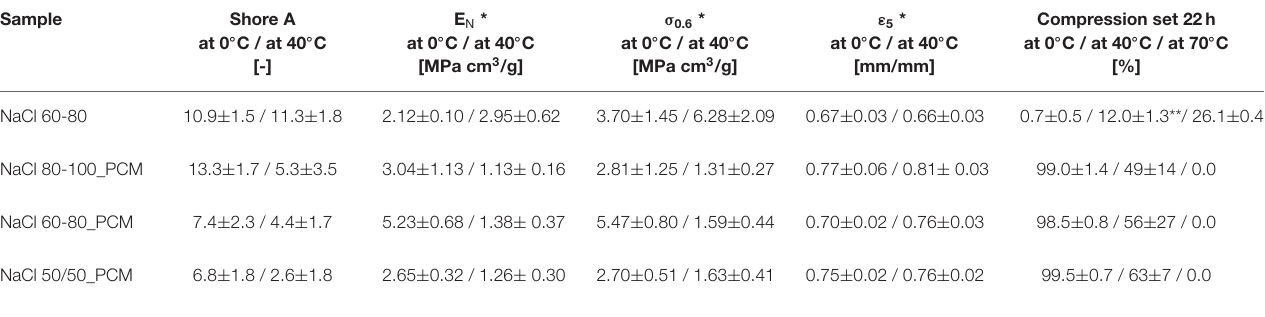
TABLE 4 | Comparison of the results of the Shore A hardness, quasi-static compression tests (normalized modulus, selected stress, and deformation) and compression set (CS) of the EPDM and TES-EPDM foams at different temperatures. Sample